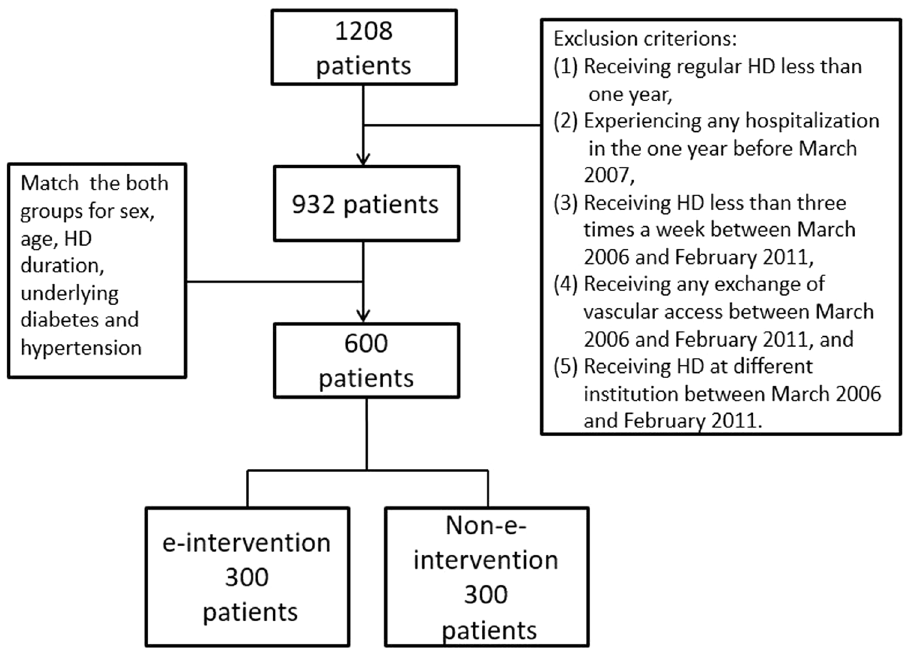
Figure 2. The consort diagram of study